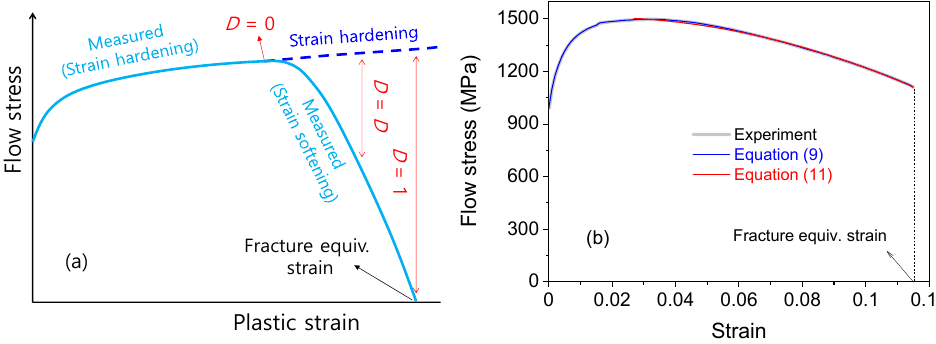
Figure 1. ( a ) Schematic of coupling between the constitutive behavior and damage model. ( b ) Stress– strain curve of high-strength steel and model predictions using Equations (9) and (11).